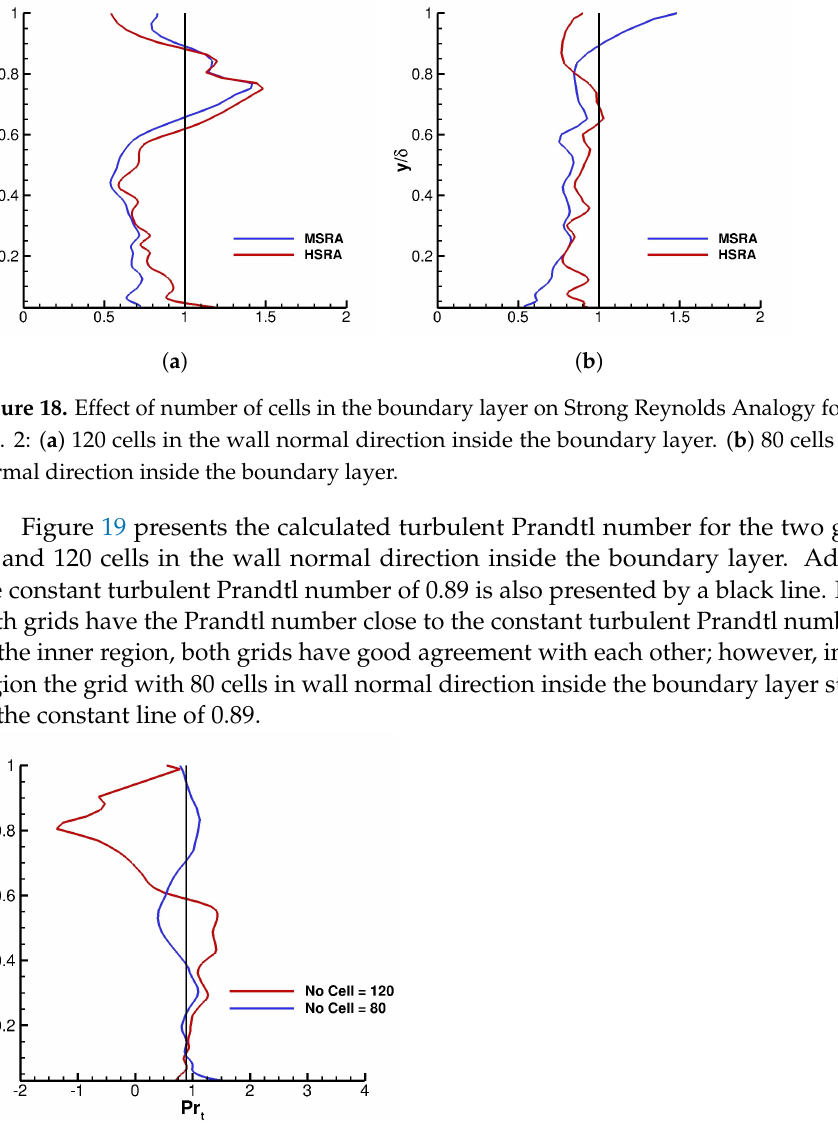
Figure 19. Turbulent Prandtl number of condition No. 2 for two grids with 80 and 120 cells in the wall normal direction inside the boundary